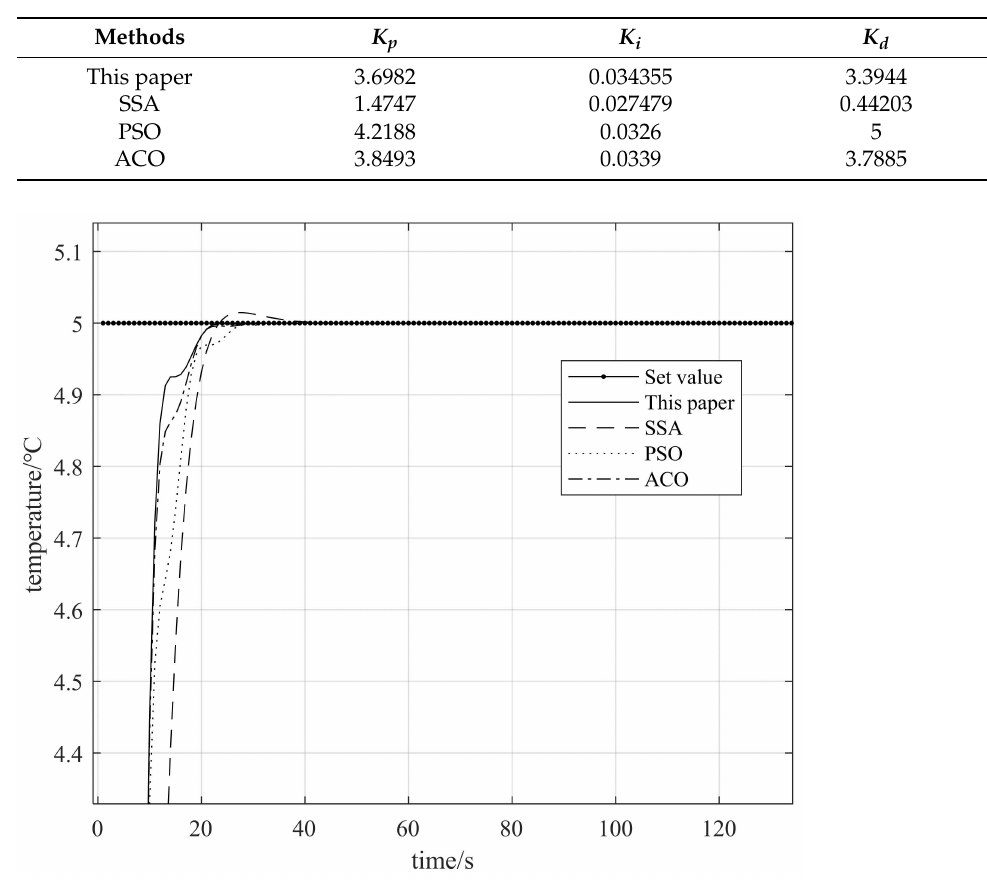
Table 1. The optimization results of each algorithm.